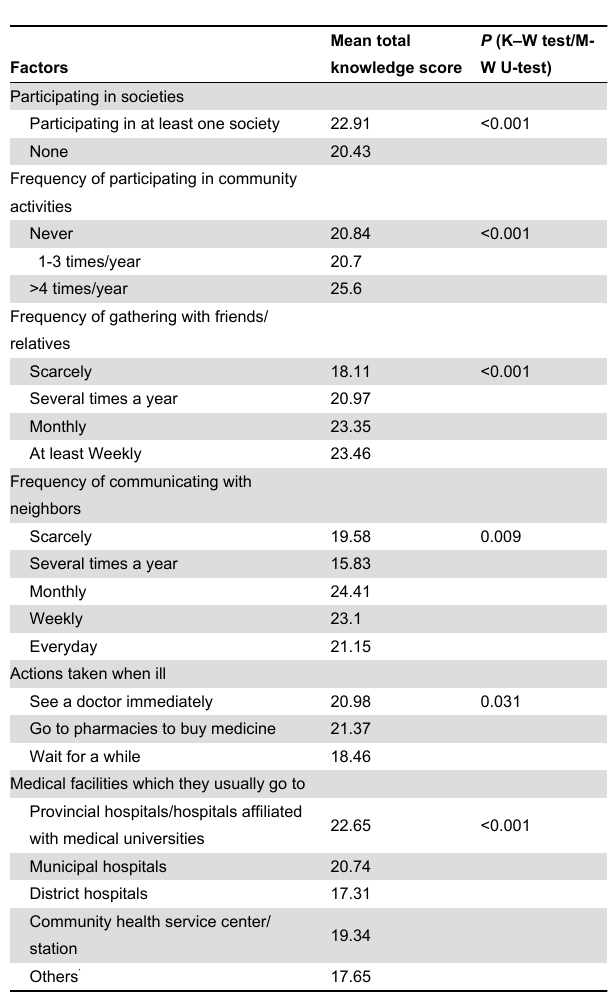
Table 4. Comparison of total knowledge among the elderly in Jinan with different